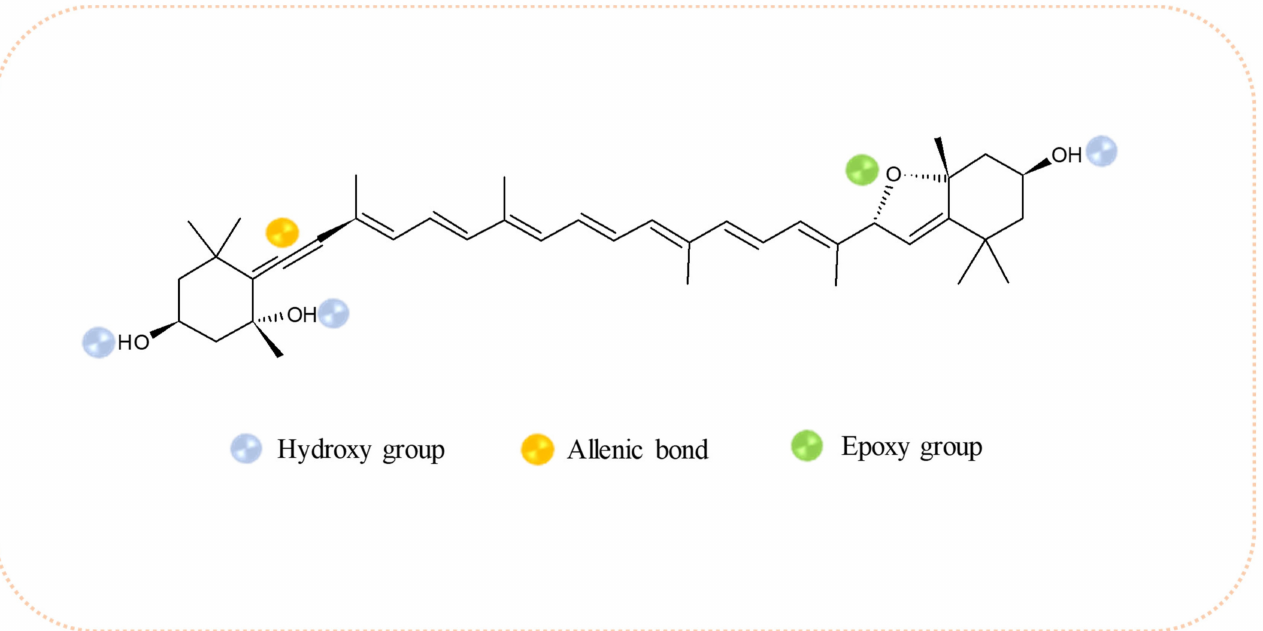
Figure 2. Chemical structure of the all- E